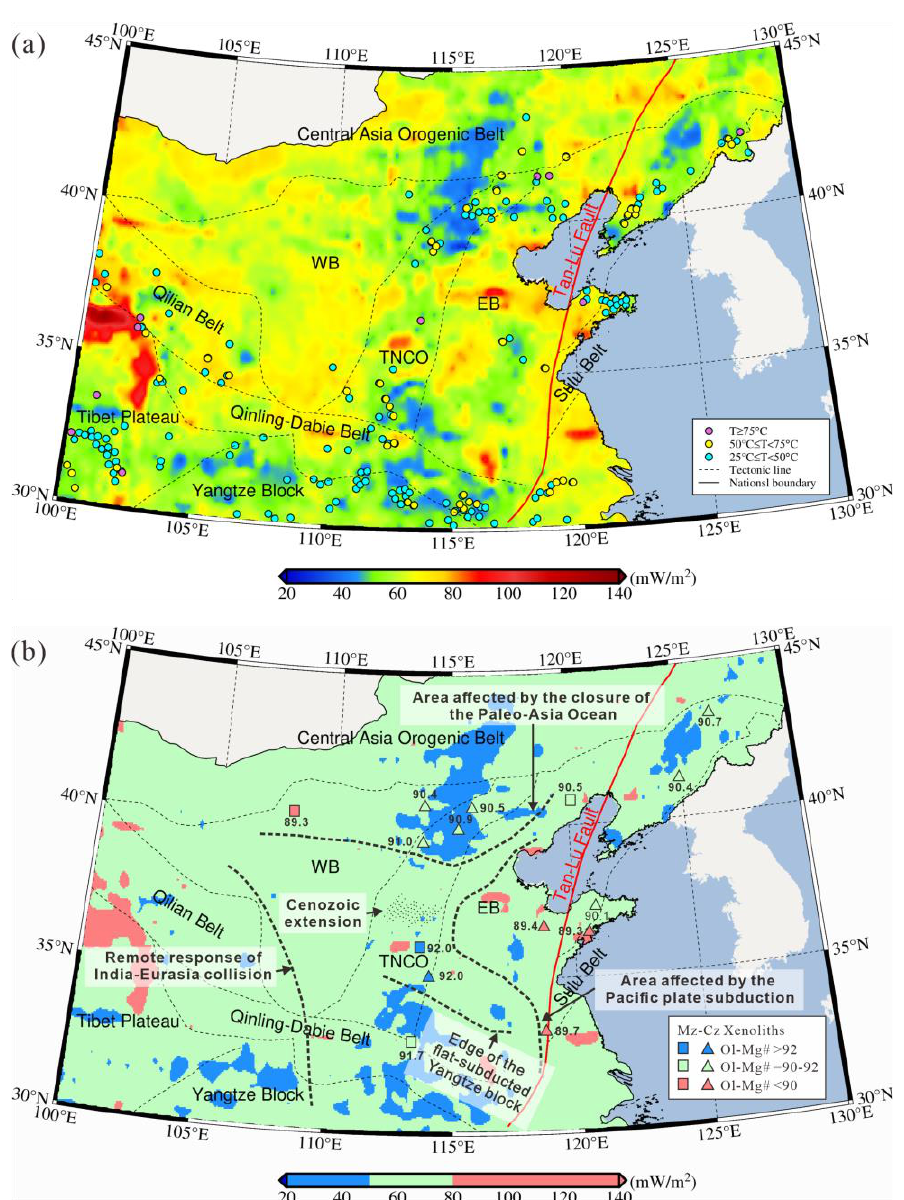
Figure 8. ( a ) Map of hot spring distribution with heat flow prediction results as a background, the colored circles represent hot springs with different temperature [36]. ( b ) Sketch map showing a simplified heat flow map based on our heat flow prediction results, with the olivine-Mg# of xenoliths inserted. Triangles and squares mark locations of Cenozoic and Mesozoic kimberlites, respectively. Numbers close to symbols mark the olivine-Mg# in the xenoliths and the color of the symbols shows the average olivine-Mg# in the xenoliths [3,41].